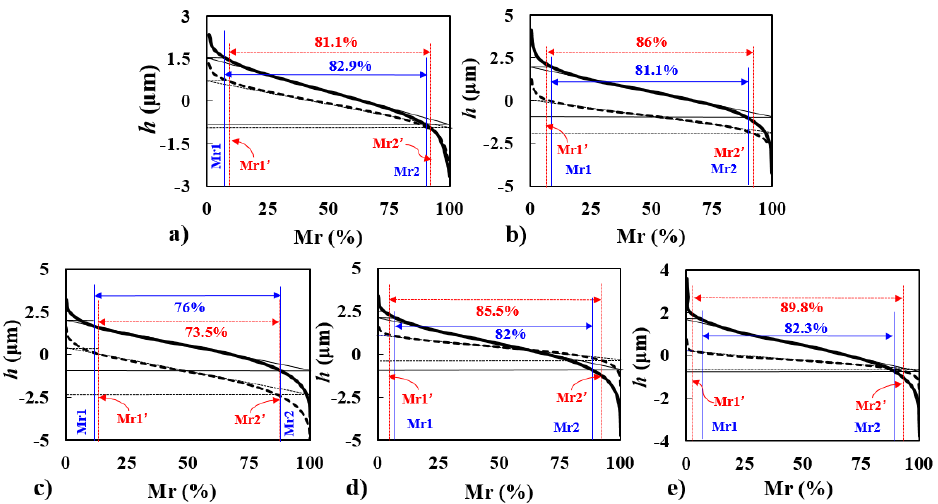
Figure 4. Abbott curves of working surfaces of the metallic sliders before and after wear: ( a ) 45 #1 steel; ( b ) 45 #2 steel; ( c ) 7075 alloy; ( d ) Q345B steel; and ( e ) QT700 cast iron.